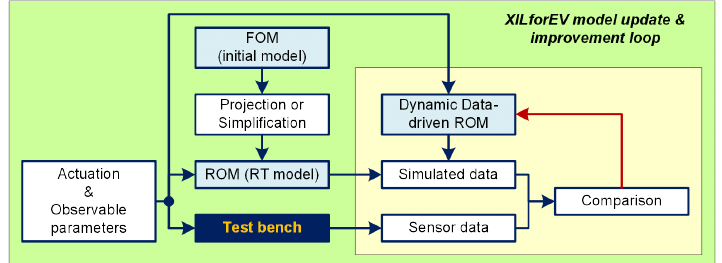
Figure 8. Use of test bench data to improve model